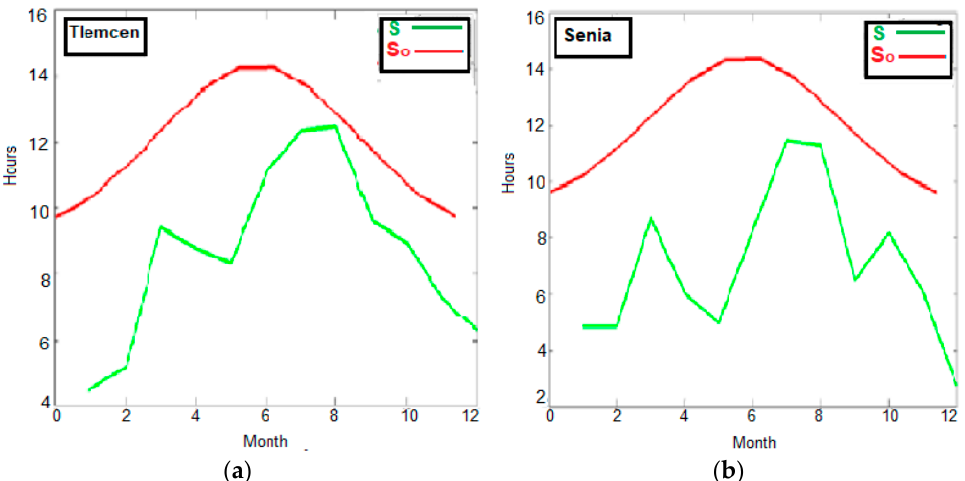
Figure 2. Monthly averages curves of measured and theoretical sunshine durations. ( a ) Curves for Tlemcen site; ( b ) Curves for Senia site.